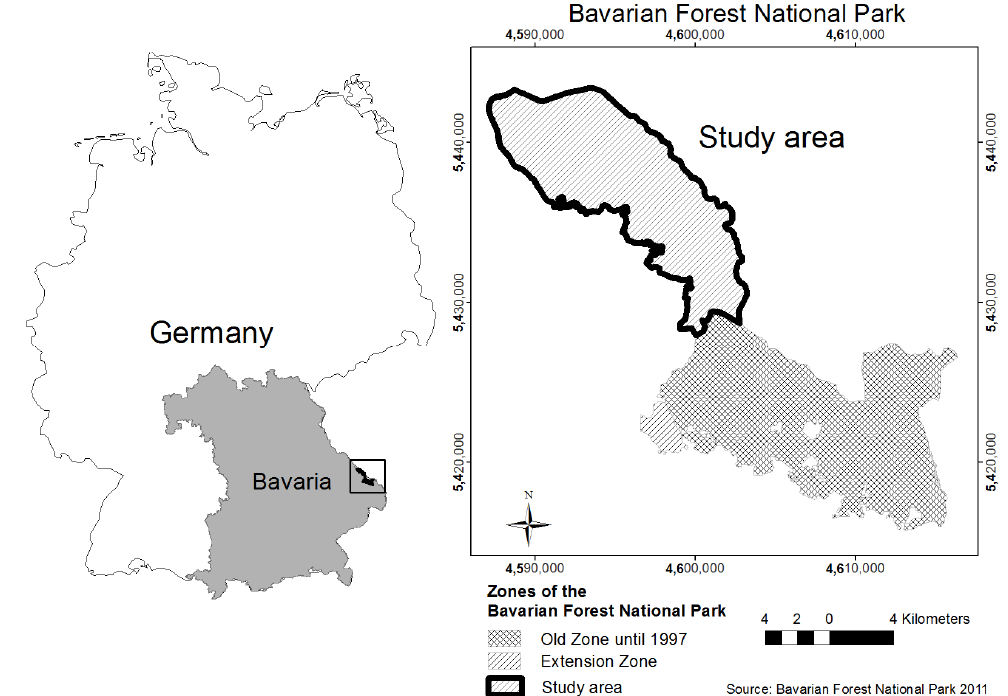
Figure 1. Location of the Bavarian Forest National